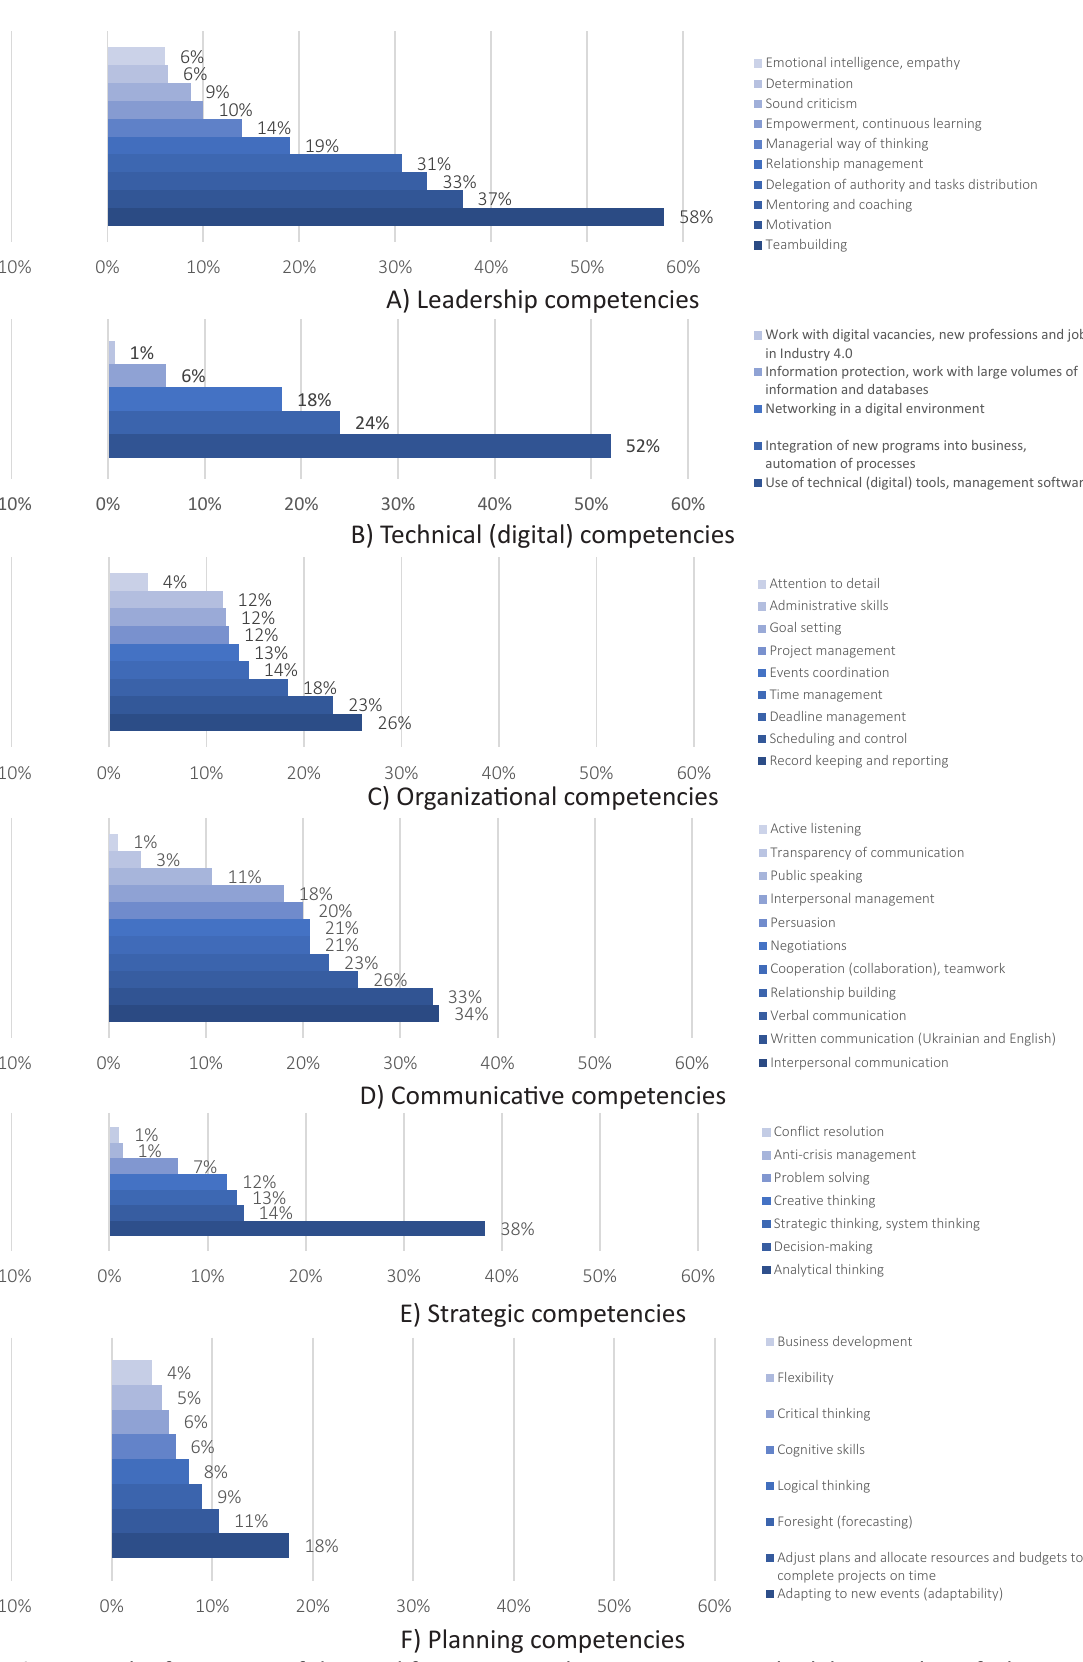
Figure 4. The frequency of demand for managerial competencies in the labor market of Ukraine in terms of